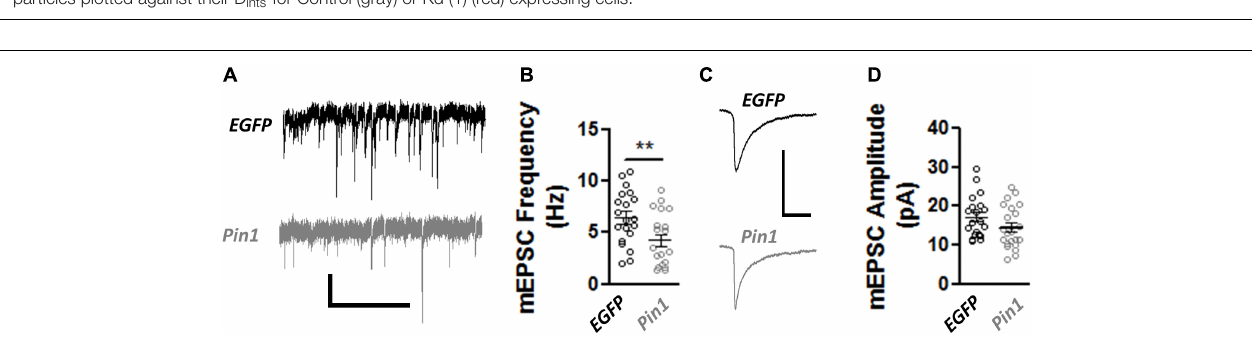
FIGURE 4 | Pin1 weakly regulates the mobility of surface AMPARs. (A) Single particle tracks for neurons expressing EGFP or Pin1. (B) Representative plots of mean squared displacement for mobile particles with instantaneous diffusion coefficient (D inst ) lower than 0.0073 µ m 2 /s and immobile particles with lower mobility. (C) Box plots showing the D inst for surface containing GluA2 receptors expressed in cells transfected with EGFP or Pin1. cells. EGFP 0.026 ± 0.0006 n = 3,473, 18 cells vs. Pin1 0.036 ± 0.0008 µ m 2 /s n = 3,367, 18 cells Mann–Whitney test, p < 0.0001. (D) Histogram showing the fraction of particles plotted against their D ints for EGFP (green) or Pin1 (dark gray) expressing cells. (E) Box plots showing the D inst for surface containing GluA2 receptors expressed in cells transfected with Control or Kd (1) shRNA. Median Control 0.009 n = 3,576, 11 cells vs. Pin1 0.006 µ m 2 /s n =, 12 cells Mann–Whitney test, p < 0.0001. (F) Histogram showing the fraction of particles plotted against their D ints for Control (gray) or Kd (1) (red) expressing cells.